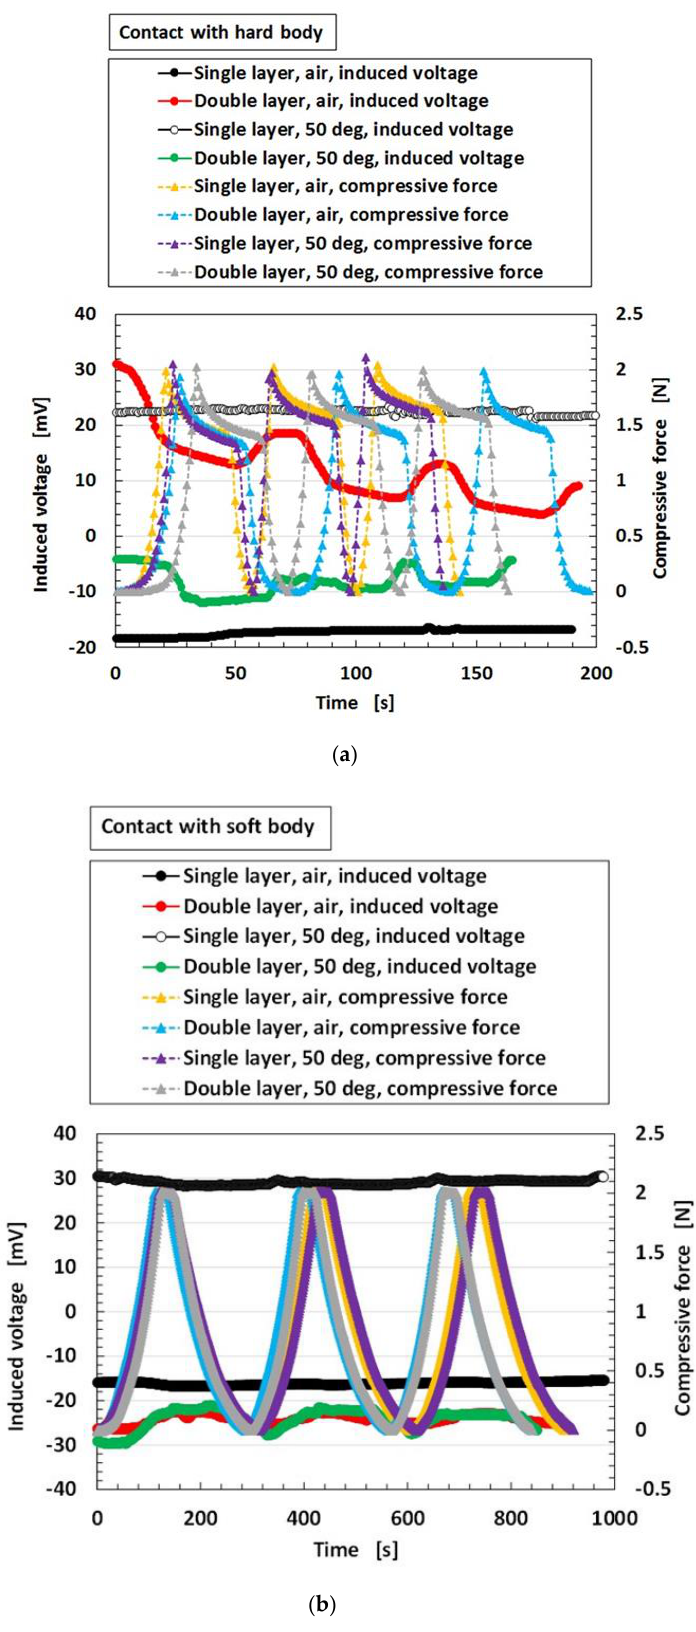
Figure 19. Comparison of induced voltage in water by compression between MCF rubber sensor with single layer produced by a combination of PDMS and PVA and that a double layer: ( a ) to a hard body ( b ) to a soft body.